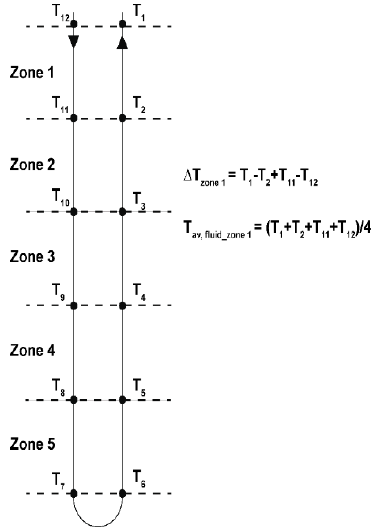
Figure 15. Schematic illustration with regard to the analysis of distributed and enhanced thermal response tests.